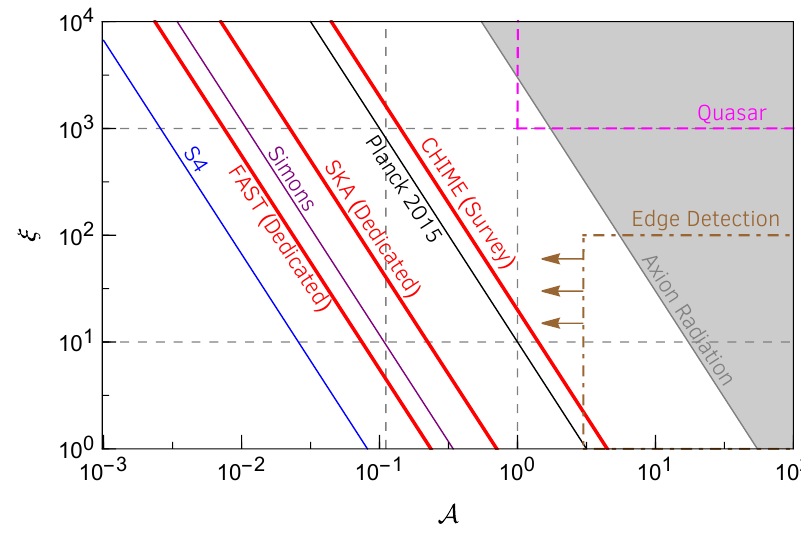
Figure 4 . We show the sensitivity of current and future experiments to the two independent parameters of an axion string network with a photon coupling; the number of axion string per Hubble volume ξ and the strength of the axion string-photon coupling A . The thick red lines show the sensitivity of a survey (CHIME) and a dedicated observation (FAST and SKA) to the radio signal coming from collisions on the string. Both lines assume that 10 − 3 of the total emitted energy is in the sensitivity band of the detector. The strings can also be looked for in the CMB due to polarization rotation effects [6]. The black solid line is the estimated current sensitivity of Planck while the purple and blue lines show the sensitivity of future CMB experiments. The shaded grey region is excluded due to emission of axion radiation and its effect on the CMB. The brown dot- dashed line shows the prospects of edge detection methods with experiments similar to the Simons observatory (very qualitative). The gray dashed gridlines mark the regions of parameter space of particular theoretical